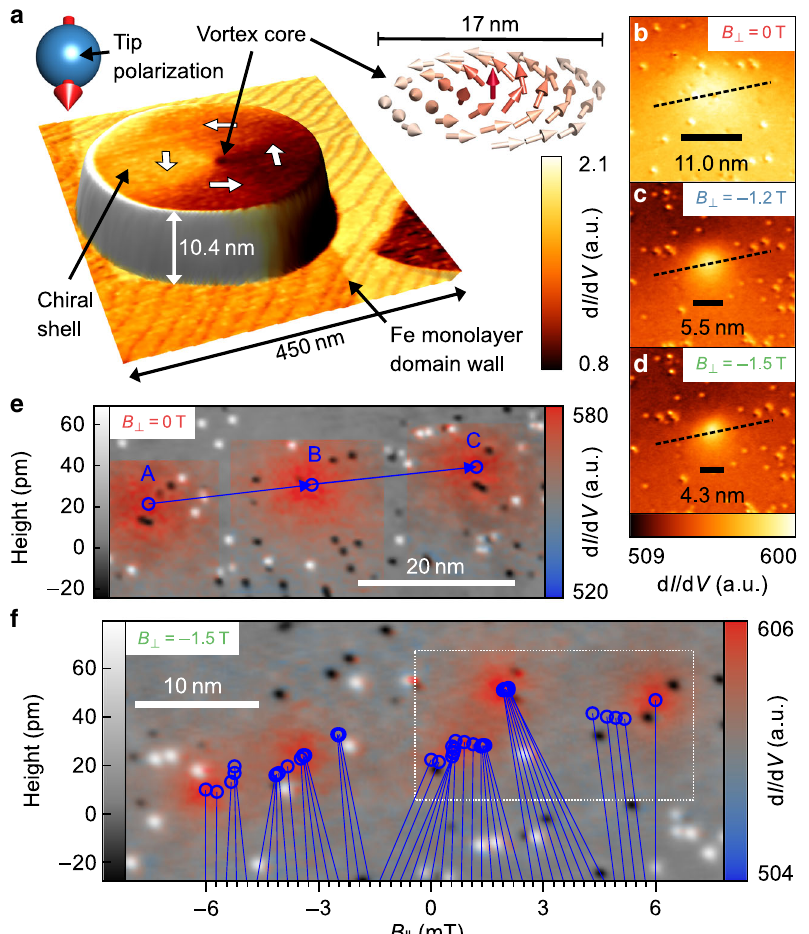
Fig. 1 Vortex core trajectories. a Superposition of STM topography (3D representation) and simultaneously acquired spin-polarized d I /d V map (color) for an Fe island on W(110), V = − 450 mV, I = 0.5 nA. Insets: sketch of deduced tip magnetization vector (left) and spin con fi guration of the vortex core (right). b – d d I /d V -images of vortex core at identical contrast, identical scale and different B ⊥ . The labeled scale bars show FWHM of m z extracted by core fi tting ( “ Methods ” ). e Superposition of topography (brightness) and three semi-transparent d I /d V maps of vortex core (color) after subtracting the signal related to in-plane magnetization (Supplementary Note 3) for B A k ¼ ð 20 : 5 ; (cid:2) 11 : 5 Þ mT, B B k ¼ ð 16 ; 0 Þ mT, and B C k ¼ ð 11 : 5 ; 11 : 5 Þ mT at B ⊥ = 0 T. Blue vectors connect the deduced vortex core centers (circles) showcasing the linear core motion. f Topography overlaid with vortex core center positions (blue circles) and fi ve selected dI / dV maps (color) for 44 equidistant B ∥ steps with Δ B ∥ = (136 − 227) μ T at B ⊥ = − 1.5 T. The core center positions are connected to the corresponding B ∥ (lower axis) by lines. The d I /d V maps (in-plane magnetization subtracted) correspond to B ∥ = − 6 mT, − 3 mT, 0 mT, 3 mT, 6 mT, V = − 2 V, I = 1 nA. A video of the vortex motion including all 45 dI / dV images is available in the supplementary movies. The island size is 255 × 165 × 10 nm 3 in b – f and 292 × 210 × 10.4 nm 3 in a